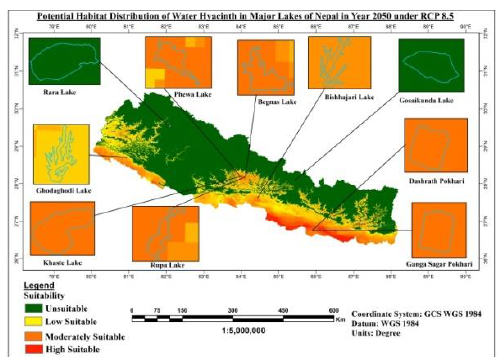
Figure 8. Potential Habitat Distribution of Water Hyacinth in the lakes of Nepal in year 2030 under RCP 2.6